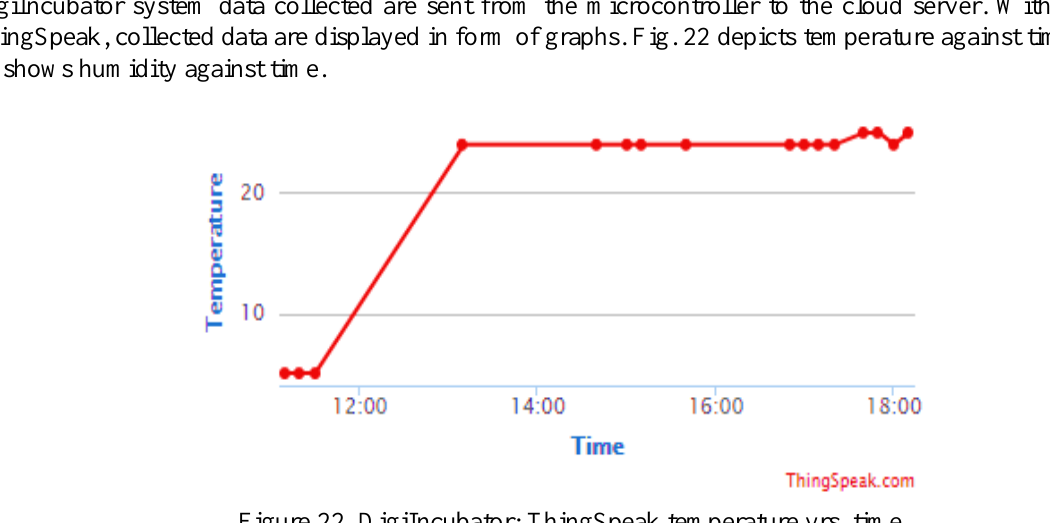
Figure 22. DigiIncubator: ThingSpeak temperature vrs.